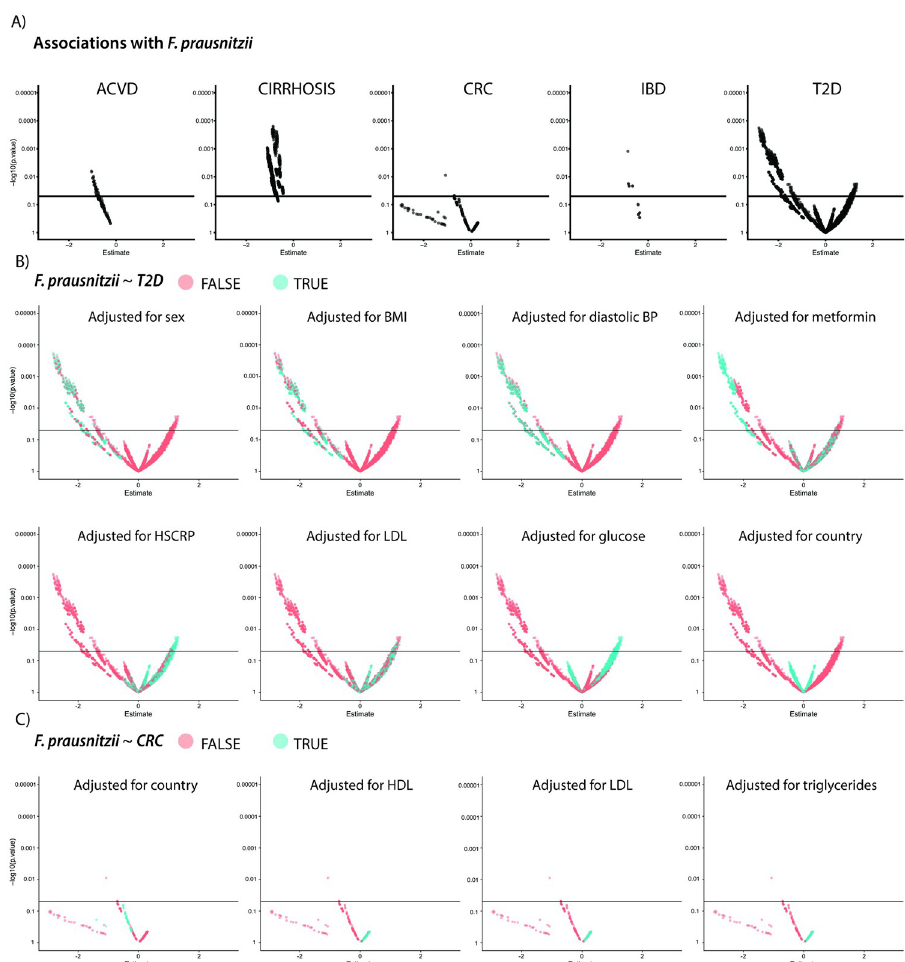
Fig 5. Exploring the impact of variable adjustment strategies on F . prausnitzii ~ disease associations. (A) VoE for the 5 phenotypes that had associations with F . prausnitzii reported in the literature. (B, C) The impact of variable adjusting strategies for (B) T2D and (C) CRC. This figure can be generated using the code deposited in https://github. com/chiragjp/ubiome_robustness and the data deposited in https://figshare.com/projects/Microbiome_robustness/ 127607. ACVD, atherosclerotic cardiovascular disease; BP, blood pressure; CRC, colorectal cancer; HDL, high-density lipoprotein; HSCRP, high-sensitivity C-reactive protein; IBD, inflammatory bowel disease; LDL, low-density lipoprotein; T2D, type 2 diabetes; VoE, vibration of